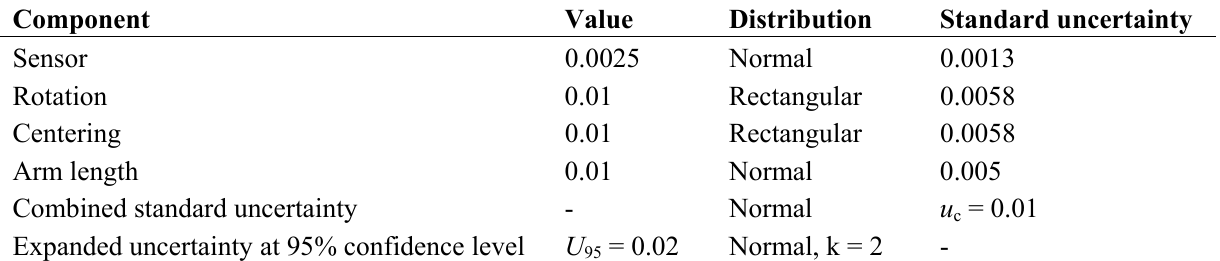
Table 1. Uncertainty budget for the inner pipe measurement system ( mm)